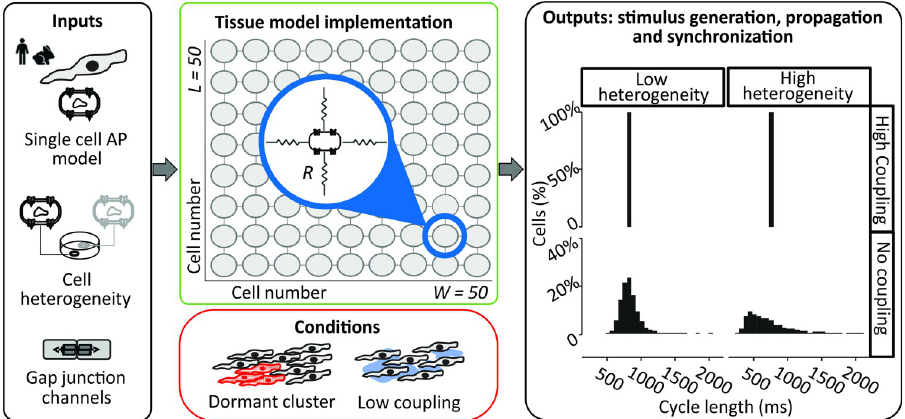
Fig 1. Schematic of multicellular study design. A multiscale mathematical modeling approach was employed to study the mechanisms of sinoatrial node excitability. The effect of cell-to-cell coupling and cellular heterogeneity on tissue synchronization were evaluated in both healthy sinoatrial nodes and those that mimicked Sinus Node Disease. Blue inset in central top panel shows that cells were connected to 4 neighbors using ohmic resistances that modeled gap junctions between adjacent